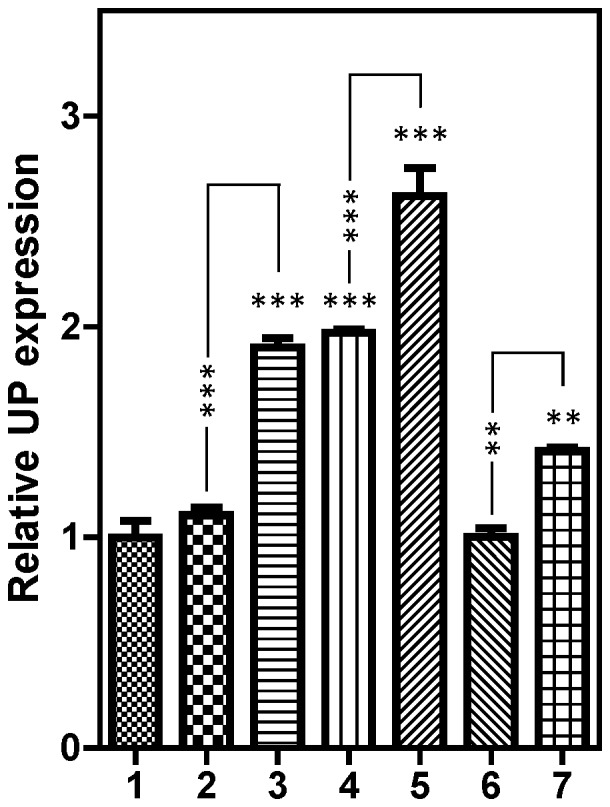
Comparative expression of uridine phosphorylase in wild-type and pyrimidine auxotrophic trypanosomes.Expression of uridine phosphorylase (UP) was assessed by Real Time PCR in WT and PYR6-5
−/− strains grown under various conditions. The results are presented normalized to the control (group1) and are the average and SE of 8 replicates. 1. Control: WT grown in HMI-9; 2. WT grown 48 h in HMI-9-tmd+100 µM uracil; 3. WT grown 48 h in HMI-9-tmd+1 mM uridine; 4. PYR6-5−/− grown 48 h in HMI-9-tmd+100 µM uracil; 5. PYR6-5−/− grown 48 h in HMI-9-tmd+1 mM uridine; 6. PYR6-5−/−long-term adapted to growth on uridine, grown 48 h in HMI-9-tmd+100 µM uracil; 7. PYR6-5−/−long-term adapted to growth on uridine, grown 48 h in HMI-9-tmd+1 mM uridine. Data were analysed with a one-way ANOVA with Tukey's correction. Horizontal asterisks indicate significant differences from control; vertical asterisks indicate significant differences between individual bars as indicated.